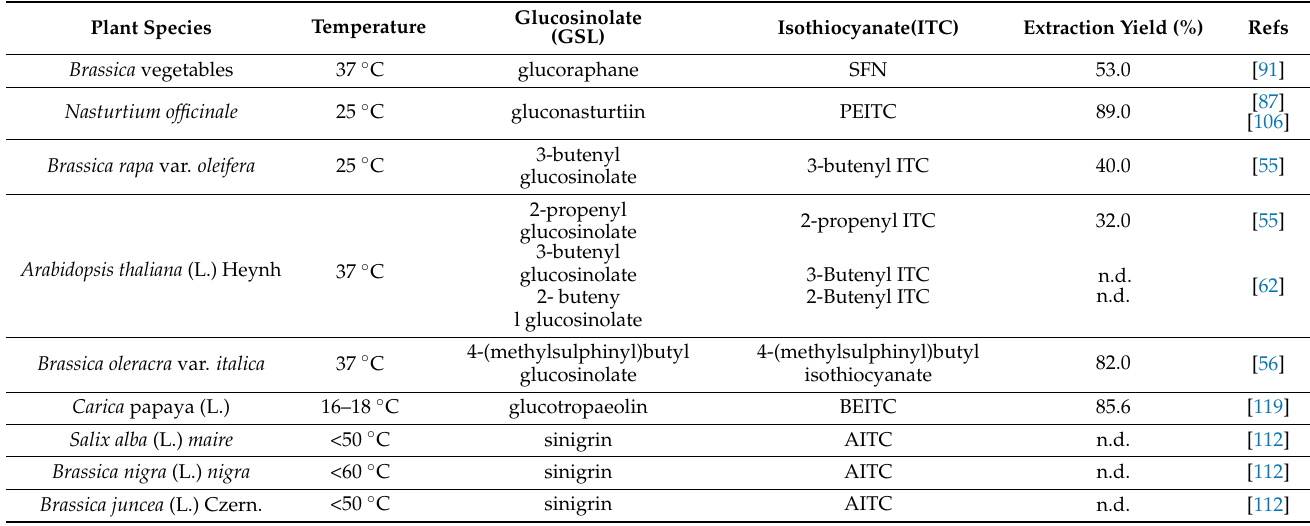
Table 3. Optimum temperature(s) for complete degradation of GSLs into their respective ITCs in various